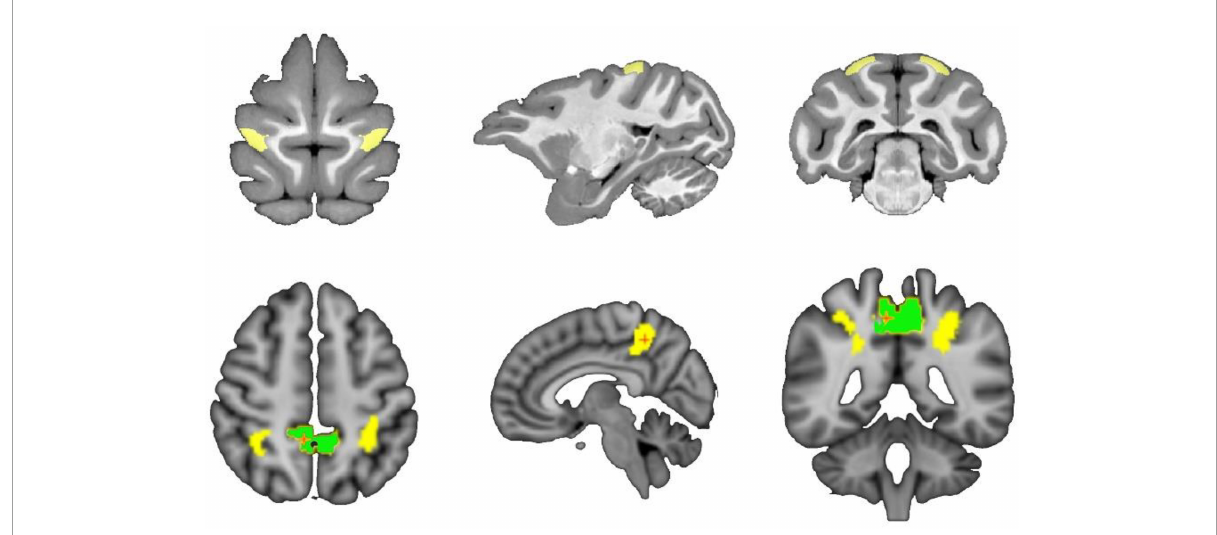
FIGURE1 Schematic diagram of the spatial location of PE in macaques and 5L and 5m in humans. The top of the schematic is the macaque brain in the D99 atlas, and the yellow area is the PE area in the macaque brain. The bottom of the schematic diagram is the human brain tissue structure in the MNI standard space, where the yellow area is the 5L area, and the green area is the 5m